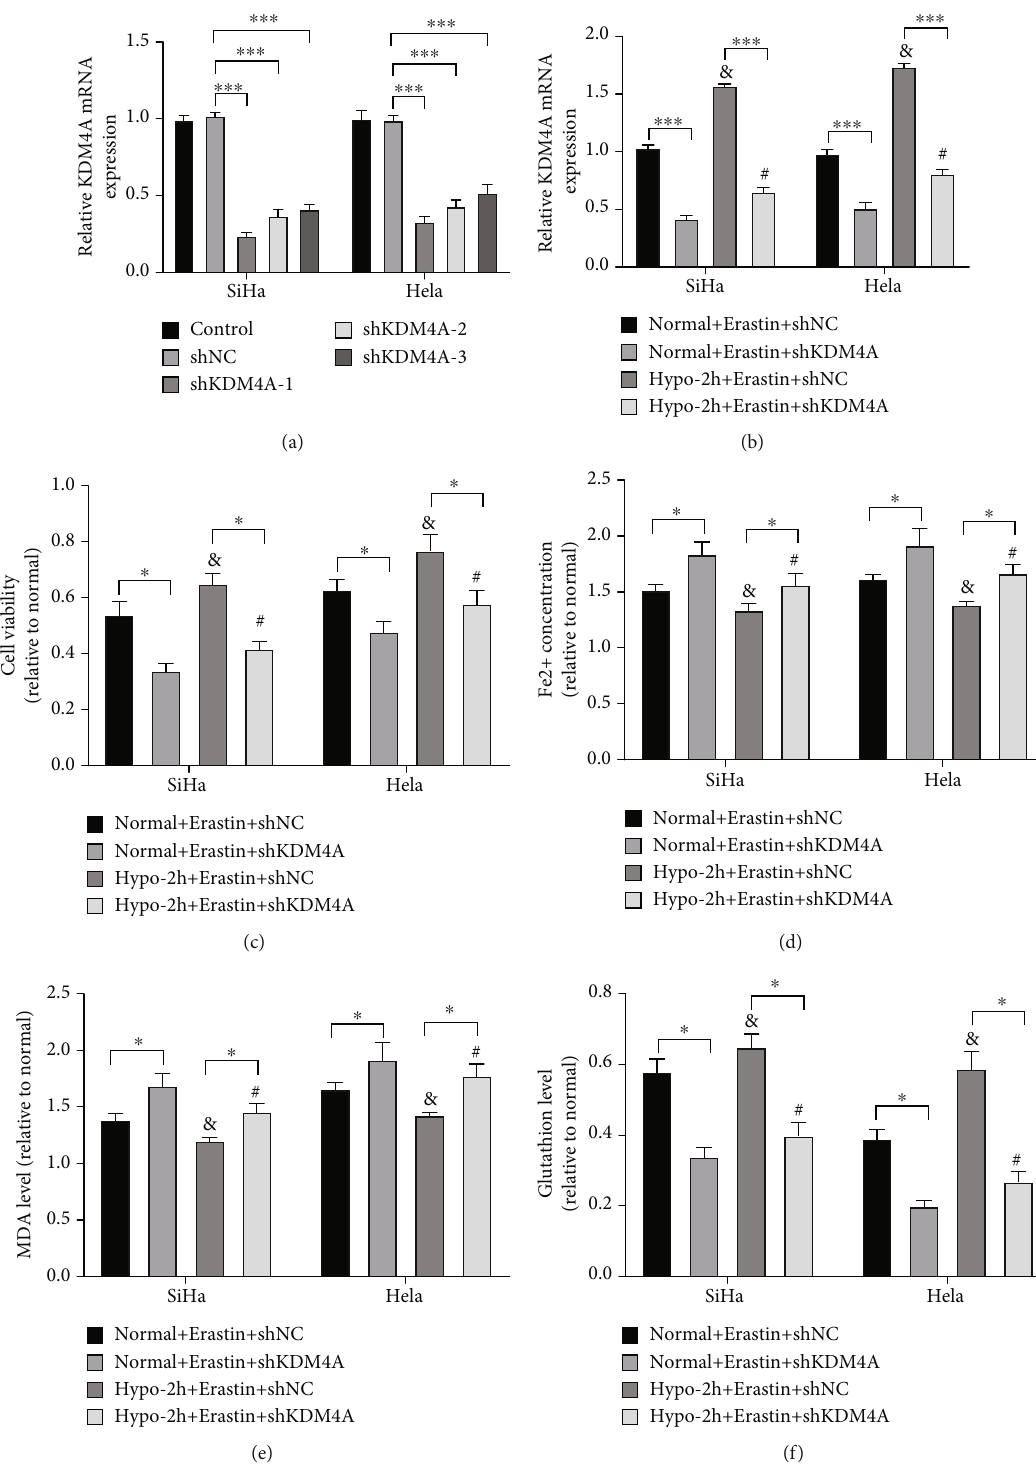
Figure 3: Hypoxia mediated KDM4A to induce ferroptosis resistance in CC cells. SiHa and Hela cell lines were transfected with shKDM4A, followed by 2-h normoxia or hypoxia treatment and 24-h incubation with Erastin. (A) The e ffi ciency of shKDM4A transfection was detected by RT-qPCR; (B) The mRNA level of KDM4A was detected by RT-qPCR; (C) Cell viability was determined by MTT assay; (D-F) The intracellular iron concentration, MDA, and GSH levels were measured using colorimetry method. The experiments were conducted in 3 replicates independently. The data were expressed as mean ± standard deviation. One-way ANOVA was used for comparisons among groups with Tukey ’ s multiple comparisons test as the post hoc test; ∗ p < 0 : 05 , & vs. the Normal + Erastin + shNC group, p < 0.05; # vs. the Normal + Erastin + shKDM4A group, p <